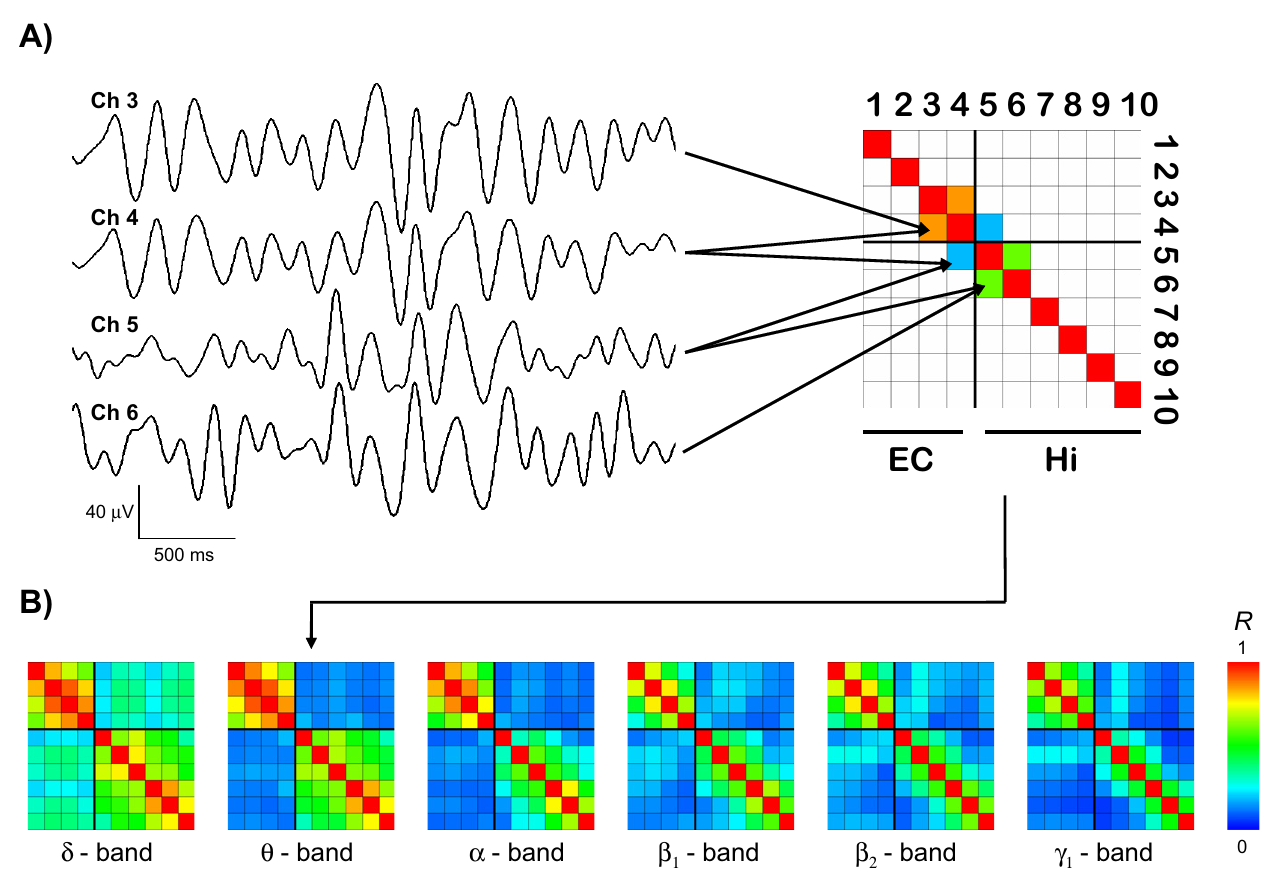
Figure 2. Exemplary results. (A) Exemplary traces of bandpass-fi ltered theta activity from two entorhinal (EC, channels 3 and 4) and two hippocampal (Hi, channels 5 and 6) recording sites. The average degree of synchrony R between these recording sites over time is color-coded and displayed in the synchronization matrix (upper right) for this EEG frequency band. In this schematic, only the three matrix entries for which the subsequent group statistics was performed are fi lled. (B) Synchronization matrices from the same patient for different EEG bands, including the theta matrix from (A) , now with all entries fi